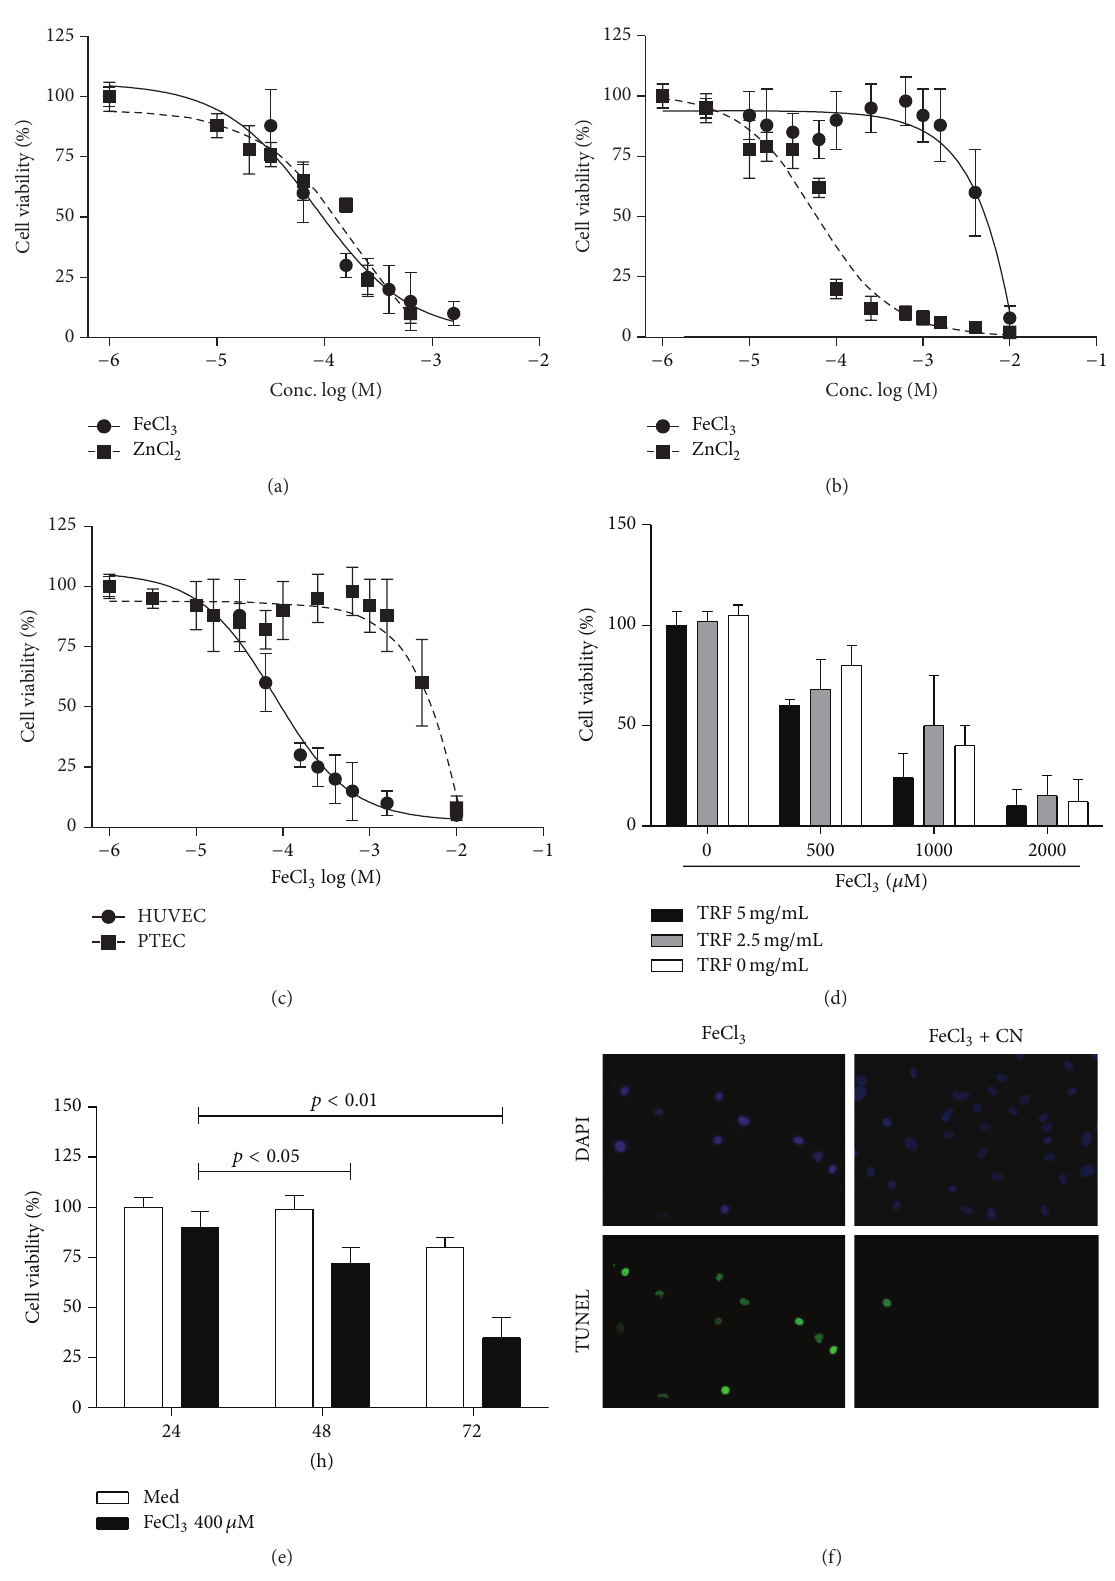
Figure 1: Iron and zinc mediated toxicity in HUVECs (a) and PTECs (b). PTECs were more tolerant to iron toxicity as compared to HUVECs (c). Ironmediated toxicity wasnot largely influenced by transferrin(TRF)(d). Although PTECswereless susceptibletoironmediated toxicity, toxicity increased upon longer exposure (e). Iron toxicity was associated with an increased number of TUNEL positive cells, which was significantly abrogated by L-carnosine